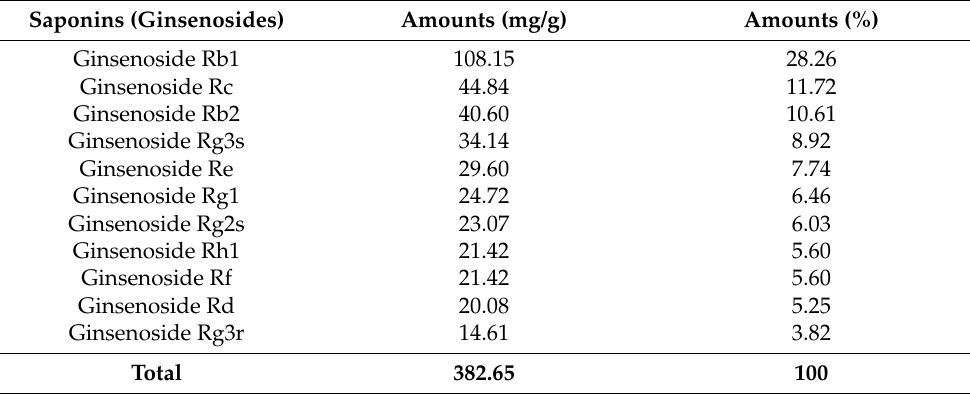
Table 1. Composition of Korean Red ginseng saponin fraction (KRGSF) used in this study. Saponins (Ginsenosides) Amounts (mg/g) Amounts (%) Ginsenoside